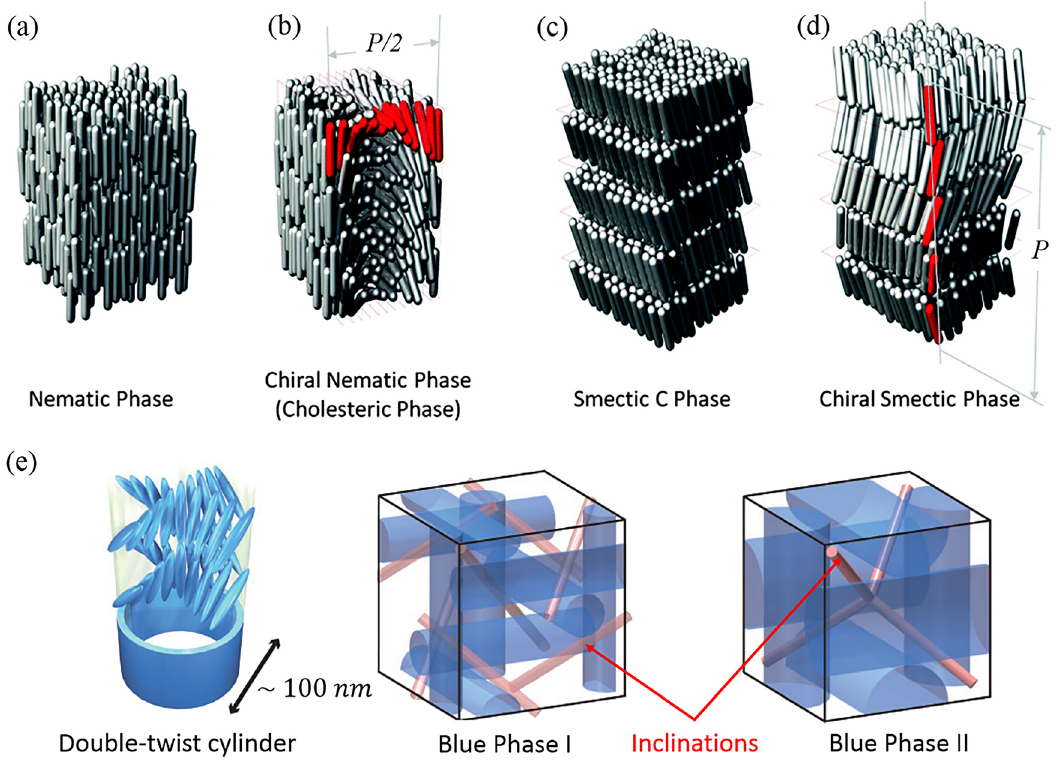
Figure 4: Schematicrepresentation of molecules ordering in different types of LC phases: nematic phase (a), cholesteric phase (b), smectic C phase(c),chiralsmecticphase(d),andtwotypesofbluephases,namelyBPIandBPIIwithmoleculesarrangementindoubletwistcylinder – a basic building block for blue phases (e). Drawings (a) – (d) adapted from [38], (e) adapted from